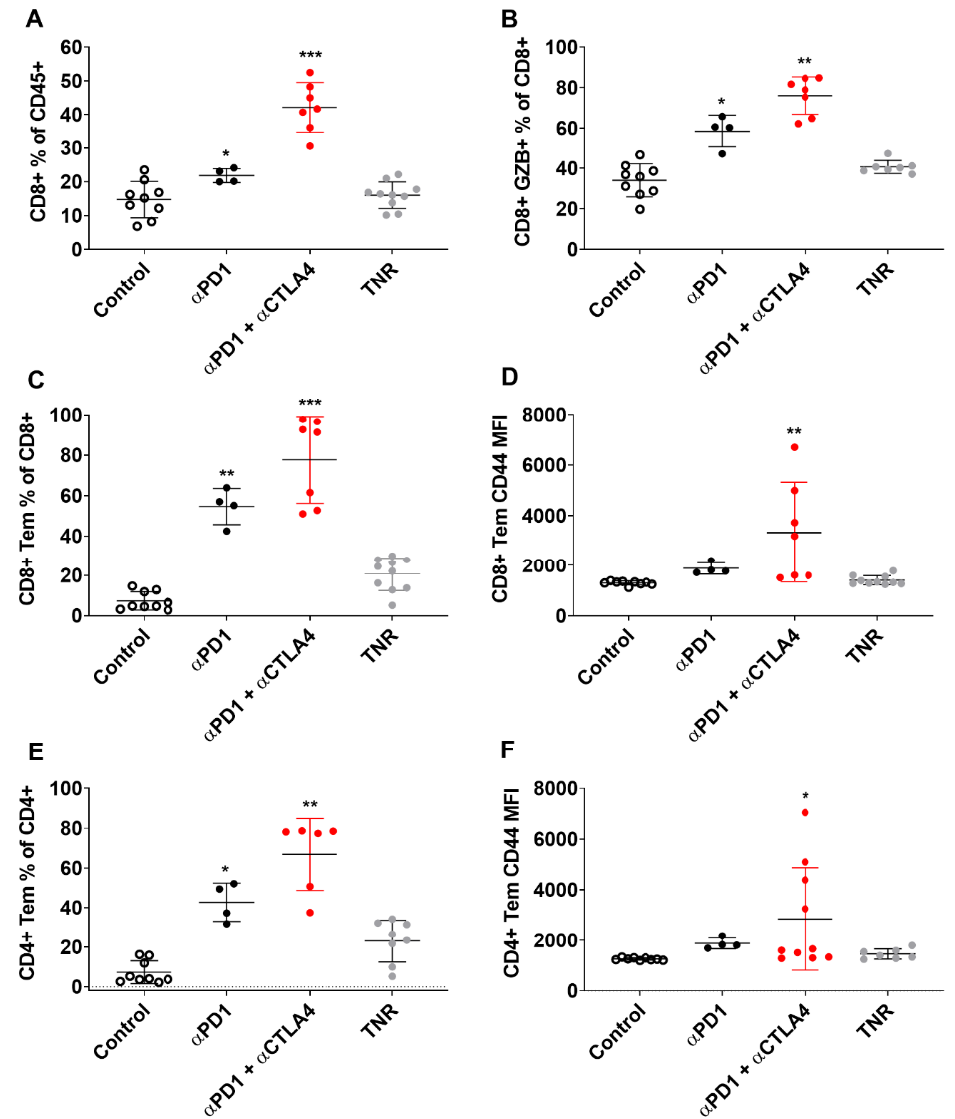
Figure 4. Multicolour Flow cytometry analysis of CT tumour associated immune cells after treatment. Percentages of ( A ) CD8 + T cells relative to CD3 + cells, ( B ) GZB+ CD8+ TILS relative to total CD8+ TILS, ( C ) CD8+ T EM cells relative to total CD8 + cells ( D ) CD8+ T EM cells relative to total CD8+ cells MFI ( E ) CD4+ T EM cells relative to total CD4 + cells ( F ) CD4 + T EM cells relative to total CD4 + cells MFI across all treatment arms. Data are shown as individual values with the mean ± S.D. and are representative of n = 5–10 mice/ group. * p < 0.05; ** p < 0.01; *** p < 0.001 compared to TNR.